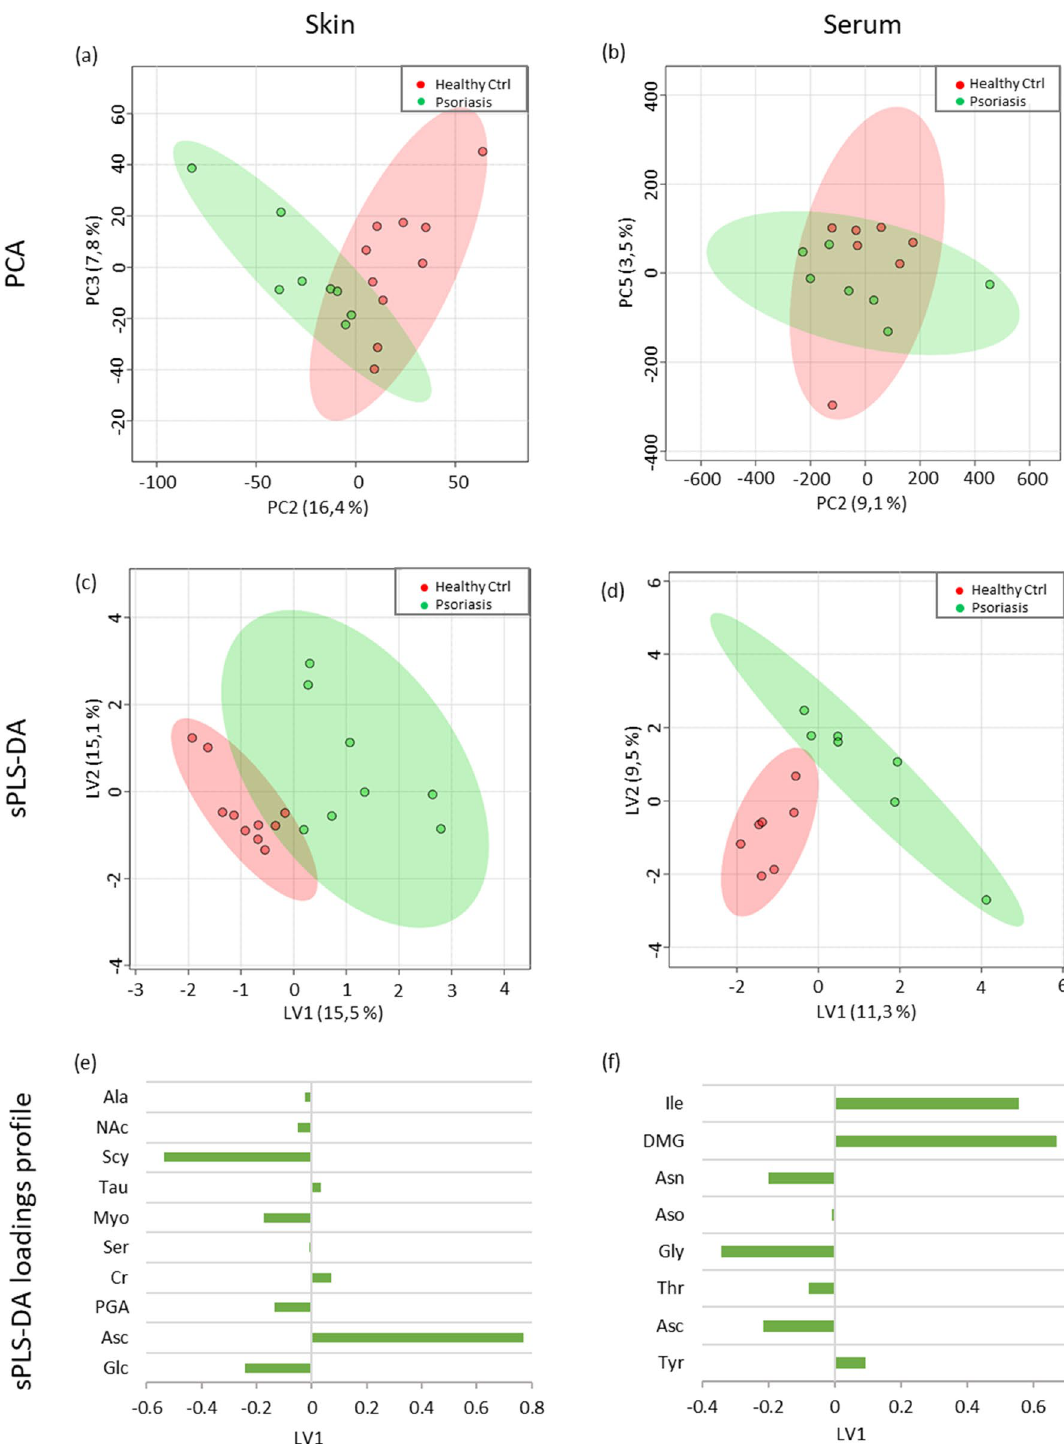
Figure 2. Scores plots of principal component analysis (PCA) of skin ( a ) and serum ( b ); and sparse partial least square-discriminant analysis (sPLS-DA) of skin ( c ) and serum ( d ) from deconvoluted NMR signals. Healthy control samples in red and psoriasis samples in green. sPLS-DA loading profiles of latent variable 1 (LV1) from skin ( e ) and serum samples ( f ). Figure produced by Microsoft Excel, Power Point, Microsoft Office Professional Plus 2019 (http:// www. office. com). No permission